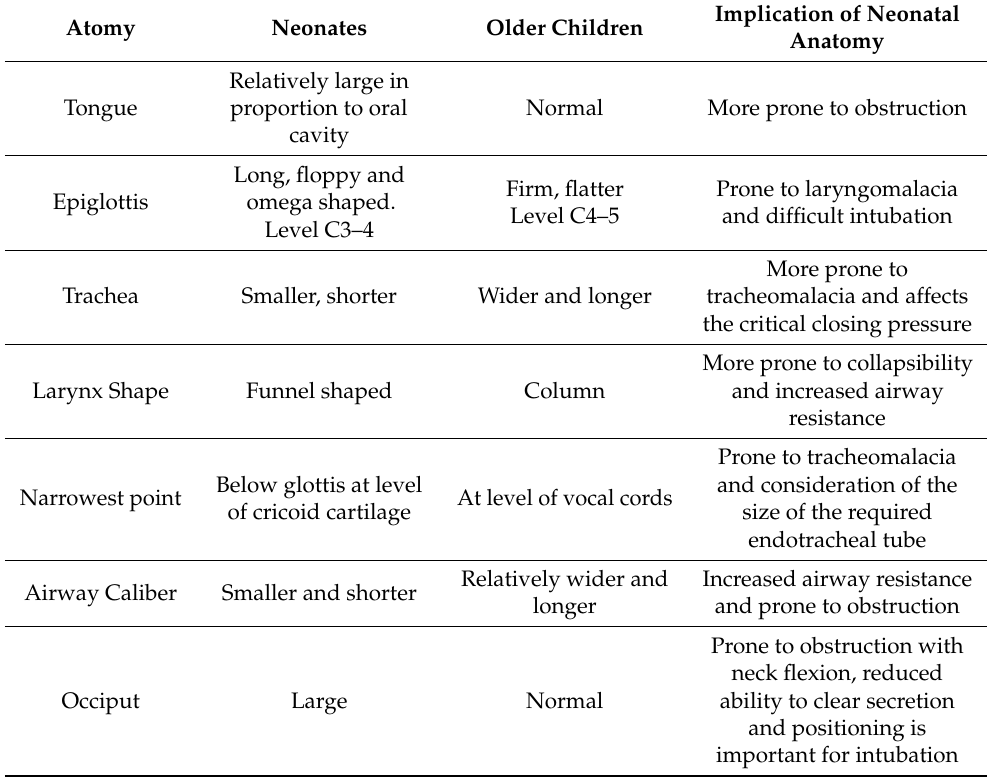
Table 1. Difference in anatomy in Neonates vs. Older children. Neonates Older Children